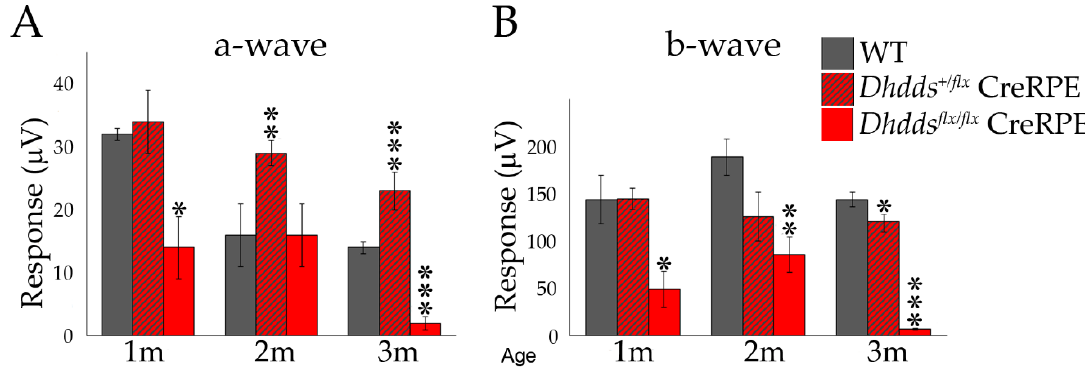
Figure 8. Photopic ERG analysis of WT, CreRPE Dhdds +/ flx , CreRPE Dhdds flx / flx mice. ( A ) a-wave responses were significantly lower in CreRPE Dhdds - / - at 1 (n = 4) and 3 (n = 4) months postnatal compared to WT (one month (1 m), n = 5; three months (3 m), n = 9) mice. ( B ) Photopic b-wave amplitudes for Dhdds +/ flx CreRPE mice showed no statistically significant di ff erences when compared to WT mice at 1 (n = 13) and 2 (n = 4) postnatal months, but were reduced by 3 months (n = 4). In contrast, the responses of Dhdds flx / flx CreRPE mice (two months (2 m), n = 6) were significantly lower when compared to WT mice at all postnatal ages examined. Statistical significance: * p < 0.05, ** p < 0.01, *** p < 0.001.